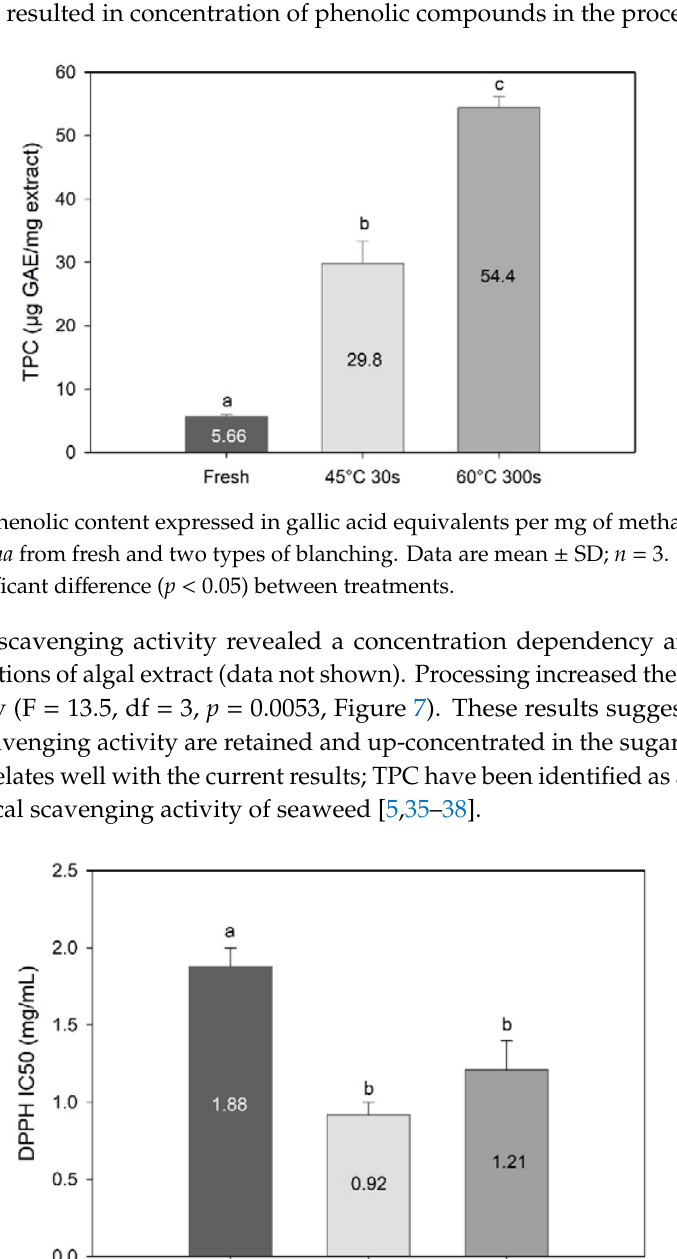
Figure 5. Total phenolic content of fresh and selected blanched samples of Saccharina latissima expressed in gallic acid equivalents per mg of freeze ‐ dried samples. Data are mean ± SD; n = 3. Different letters represent a significant difference between treatments ( p ˂ 0.05).